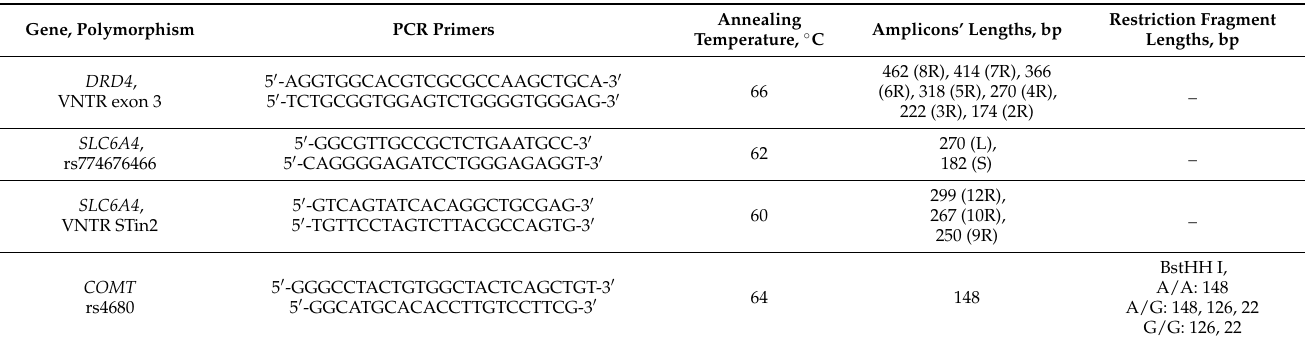
Table 1. Conditions for PCR and restriction analysis for the VNTR of exon 3 in DRD4 , VNTR STin2 and rs774676466 in SLC6A4 , and rs4680 of COMT . R: the number of repeats.